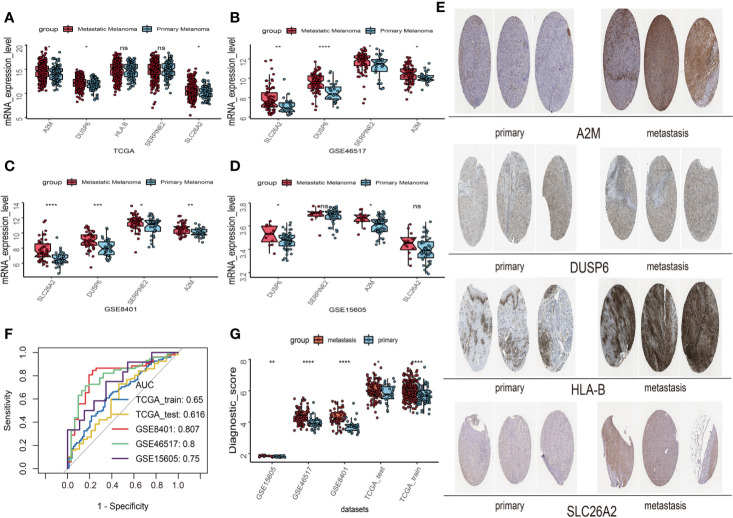
Construction and validation of the diagnostic model in melanoma patients. (A) The expression values of 5 survival-related metastasis related genes (MRGs) between metastatic and primary melanoma in TCGA dataset. (B) The expression values of 4 survival-related MRGs between metastatic and primary melanoma in GSE46517. (C) The expression values of 4 survival-related MRGs between metastatic and primary melanoma in GSE8401. (D) The expression values of 4 survival-related MRGs between metastatic and primary melanoma in GSE15605. (E) High expression of 4 metastasis related genes by immunohistochemistry in The Human Protein Atlas dataset. (F) Receiver operating characteristic (ROC) curves for diagnostic model in multiple datasets. (G) Distribution of diagnostic scores in different datasets. The box plots indicate the median value and interquartile range of diagnostic scores. *p < 0.05; **p < 0.01; ***p < 0.001; ****p < 0.0001.